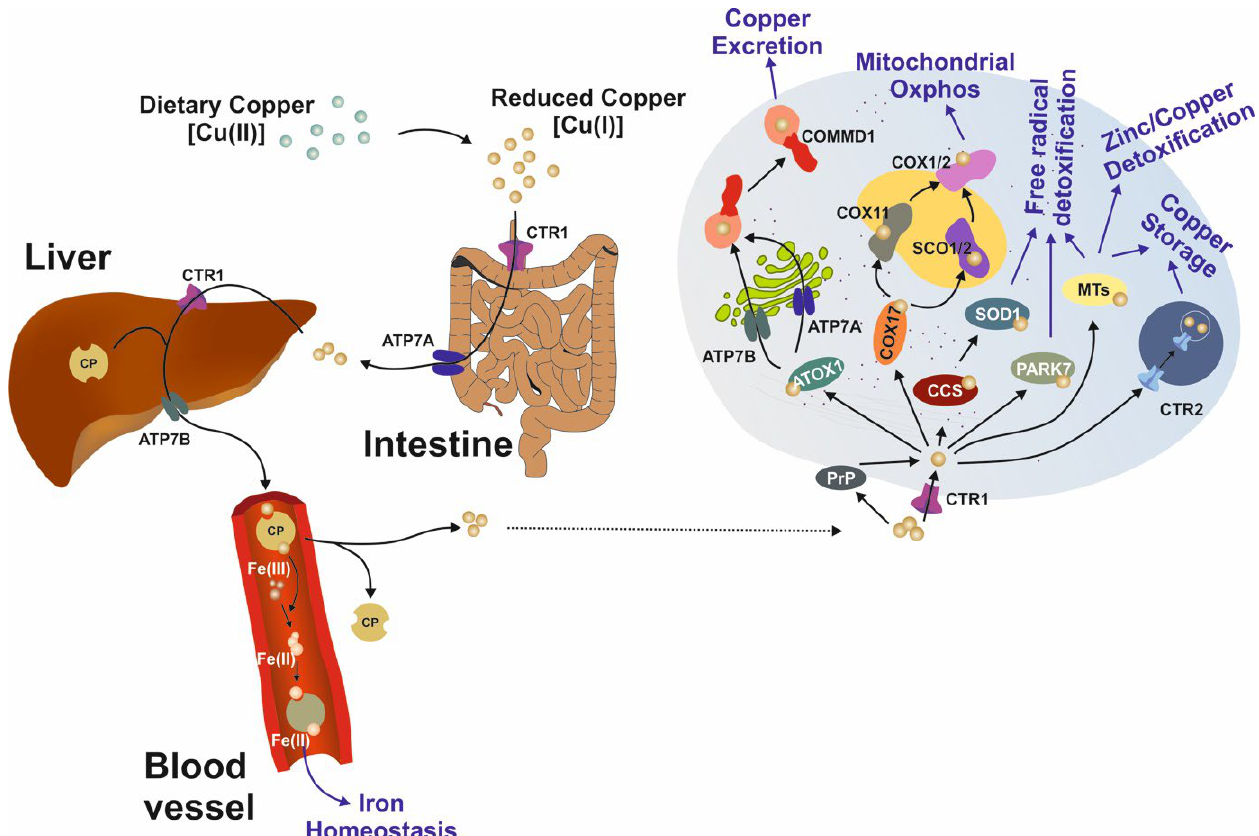
Figure 1. Schematic diagram of copper pathways and transport. Dietary copper is taken up in the gastrointestinal tract via CTR1 and excreted via ATP7A into the blood stream. It enters the liver via the portal vein and CTR1 mediates uptake into hepatocytes. Once bound to ceruloplasmin (CP), copper is excreted from the liver into the blood stream via ATP7B. The recycling of CP-released copper into the hepatocytes seems of very minor relevance (dotted line). A detailed image of intrahepatic copper transport is depicted on the right. Copper can be bound to ATOX1 and, following ATP7A- and ATP7B-mediated transport through the trans-Golgi network (TGN), copper binds to COMMD1 and is excreted. Intracellular copper in involved in mitochondrial oxidative phosphorylation by binding to COX17, COX11, SCO1/2, and COX1/2. Copper-initiated free radicals can be detoxified via the actions of CCS and SOD1, or alternatively by PARK7 and/or MT. Finally, intracellular copper can be stored in specific compartments via CTR2. Abbreviations: ATOX1, antioxidant protein 1; ATP7A, P-type ATPase 7A; ATP7B, P-type ATPase 7B; CCS, copper chaperone for SOD; COMMD1, copper metabolism murr1 domain 1;COX11, cytochrome C oxidase 11; COX17, cytochrome C oxidase copper chaperone 17; CP, ceruloplasmin; CTR1, copper transporter1; CTR2, copper transporter 2; MT, metallothionein(s); PARK7, Parkinson disease 7; PrP, Prion protein; SCO1/2, synthesis of cytochrome c oxidase 1/2; SOD1, superoxide dismutase 1. This figure is adapted from [16]. The vast majority ( ± 40%) of dietary copper is transported to the bone, 20% to